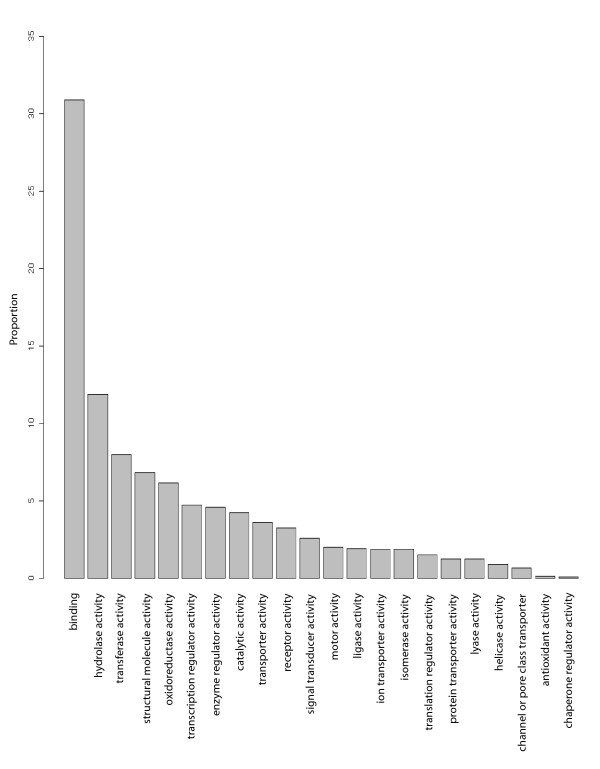
GO categories of genes identified in L. elliptica data by BLAST sequence similarity searching.